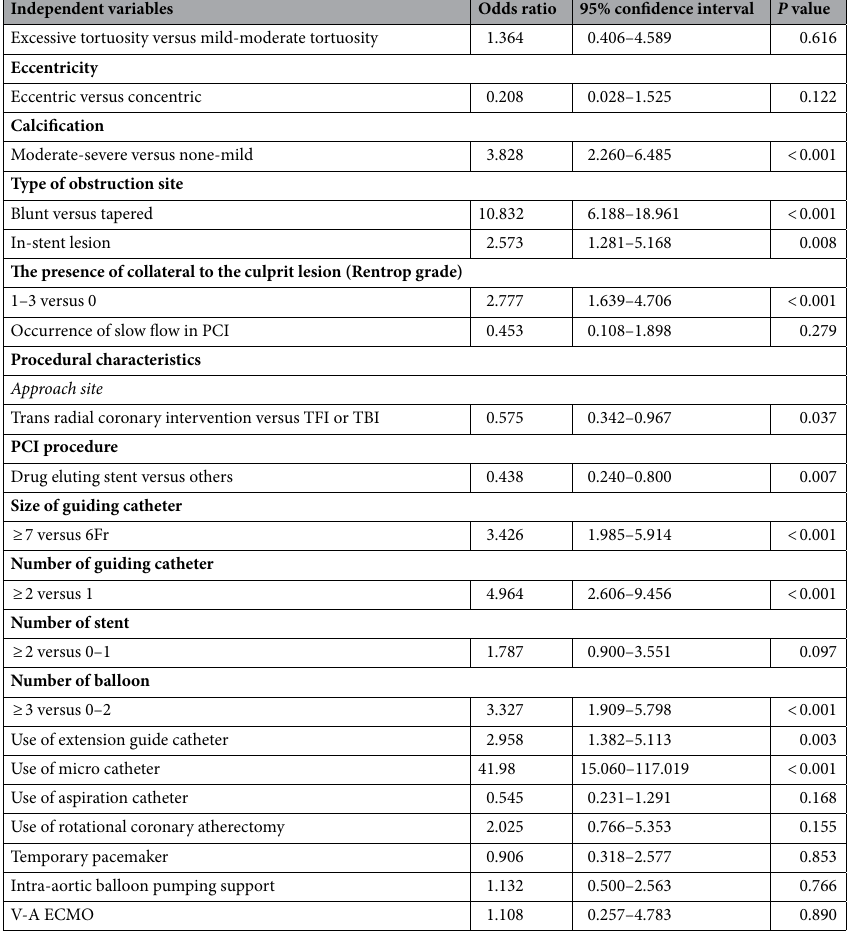
Table 2. Univariate logistic regression analysis to find association with the difficulty in crossing the culprit lesion.